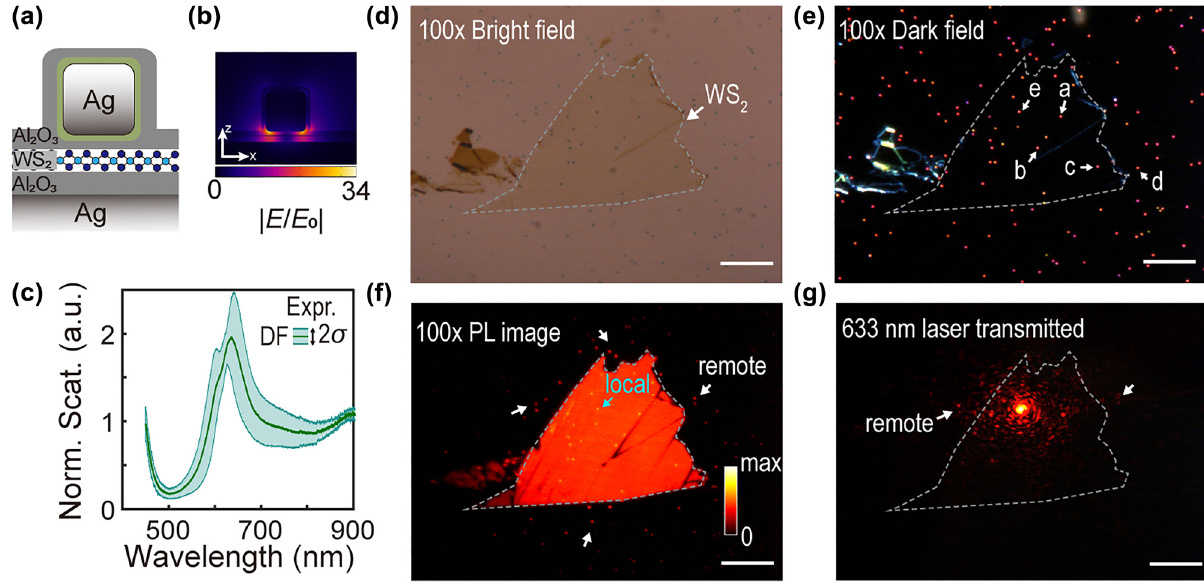
hybrids. (a) Schematic of NCoM-WS hybrid composed of Ag nanocube and Ag Figure 3: Demonstration of remote properties on NCoM-WS 2 2 . (b) The field enhancements of the hybrid system. The plane shown is the central film, spaced by alumina layers and monolayer WS 2 cross-section of xz -plane. (c) The average dark-field scattering over 10 samples with green shades indicating the standard deviation. Bright field (d) and dark field (e) images of the hybrid system. (f) PL image excited by a mercury lamp. (g) Optical images of SPPs launched and scattered out by the NCoMs. Receiving NCoM was locally excited by a 633 nm laser. Gray dashed lines in (d–g) mark the edges of monolayer . Scalebars represent 10 μ m. (f) and (g) share a same WS 2